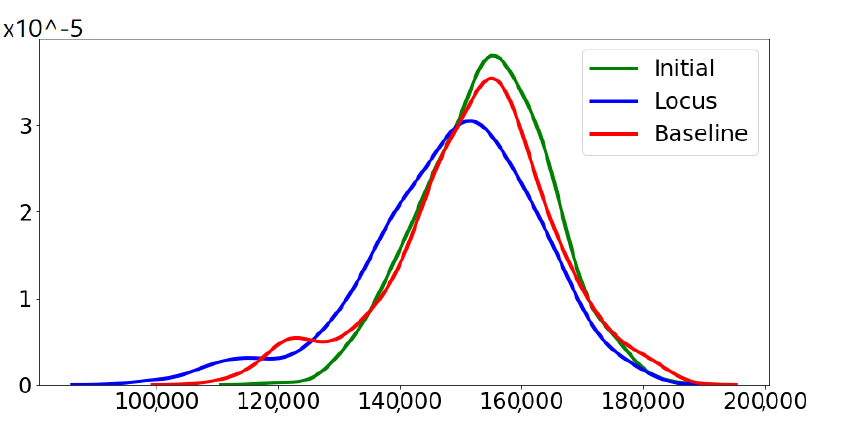
Figure 4. The figure shows the distribution of the fitness of the chromosomes in a generation in three different cases, initial generation, 20th generation using baseline mutation and the 20th generation using locus mutation. Locus mutation is not just attaining better chromosomes, smaller fitness, but also moving the entire distribution closer to